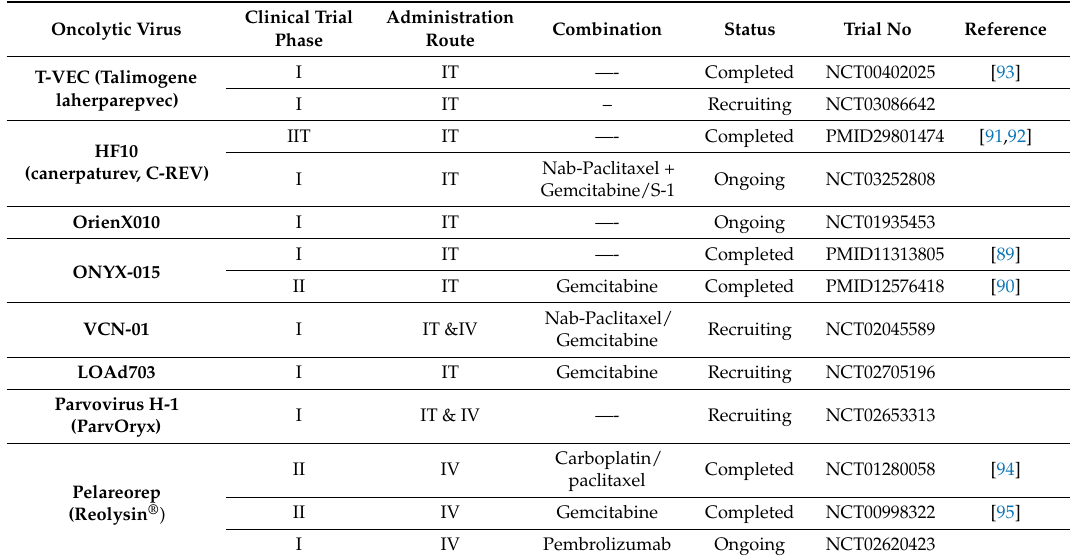
Table 4. The clinical trials of oncolytic viruses in patients with pancreatic